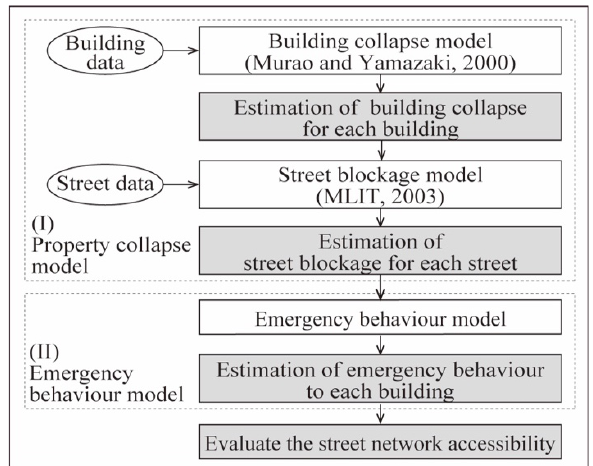
Figure 1. Overview of simulation model